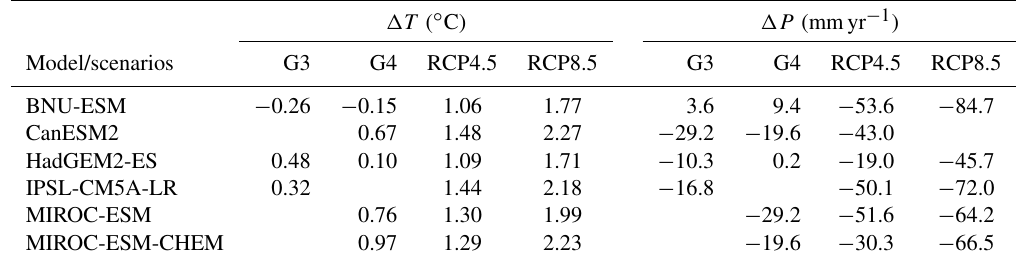
Table 2. Summer mean temperature ( (cid:49)T ) and annual solid-precipitation ( (cid:49)P ) anomalies over 2030–2069 for each model and scenario in the glaciated region of high-mountain Asia relative to their RCP4.5 2010–2029 values.